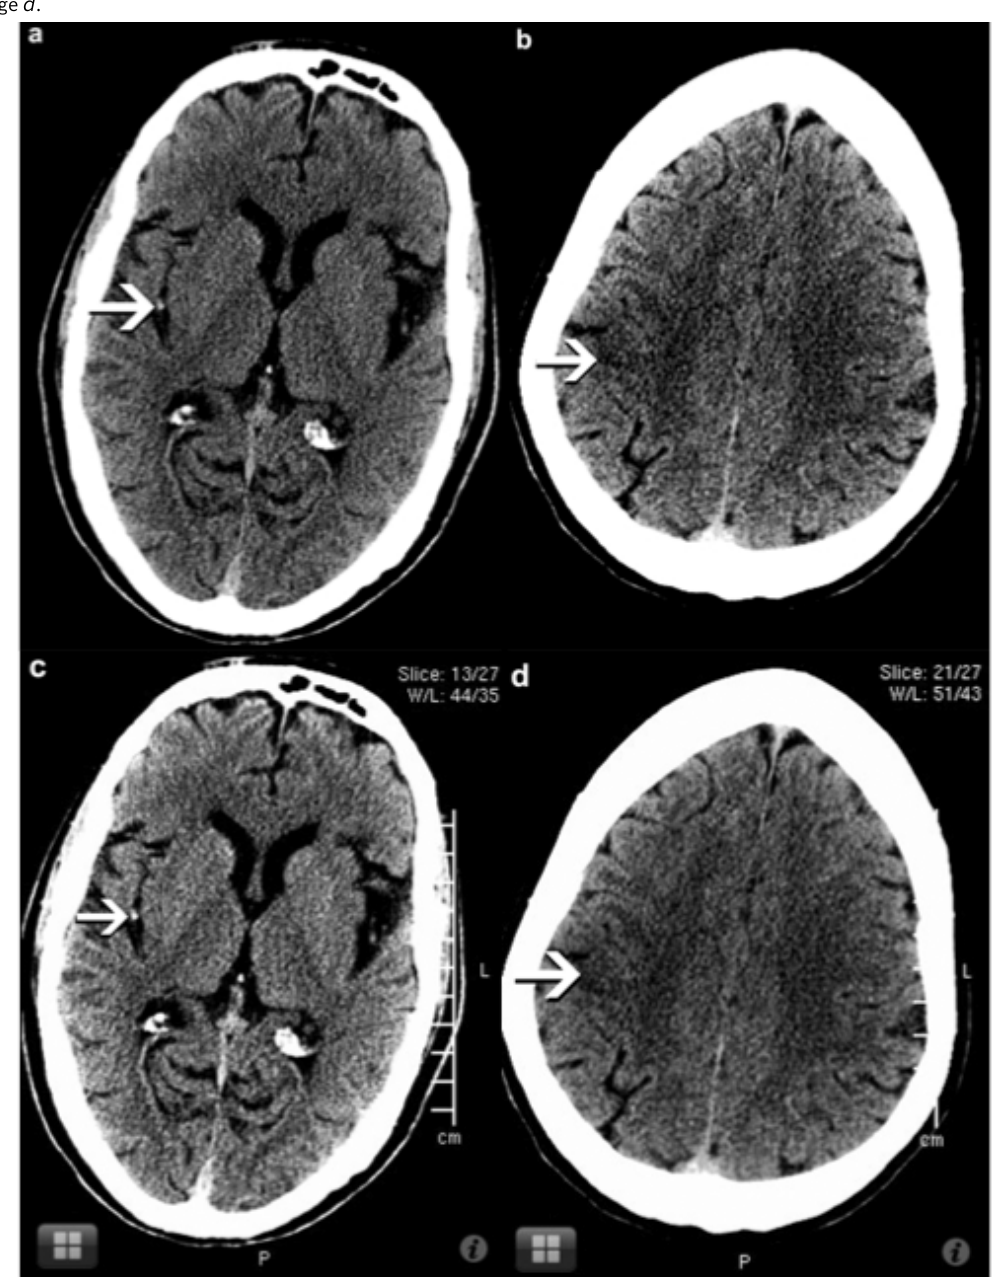
Figure 2. In image a , the workstation monitor images show a dense MCA sign (arrow) and in image b , acute ischemic change in the ASPECTS M6 region (arrow). Corresponding iOS device images show a dense MCA sign (arrow) in image c and acute ischemic change in ASPECTS M6 region (arrow) in image d